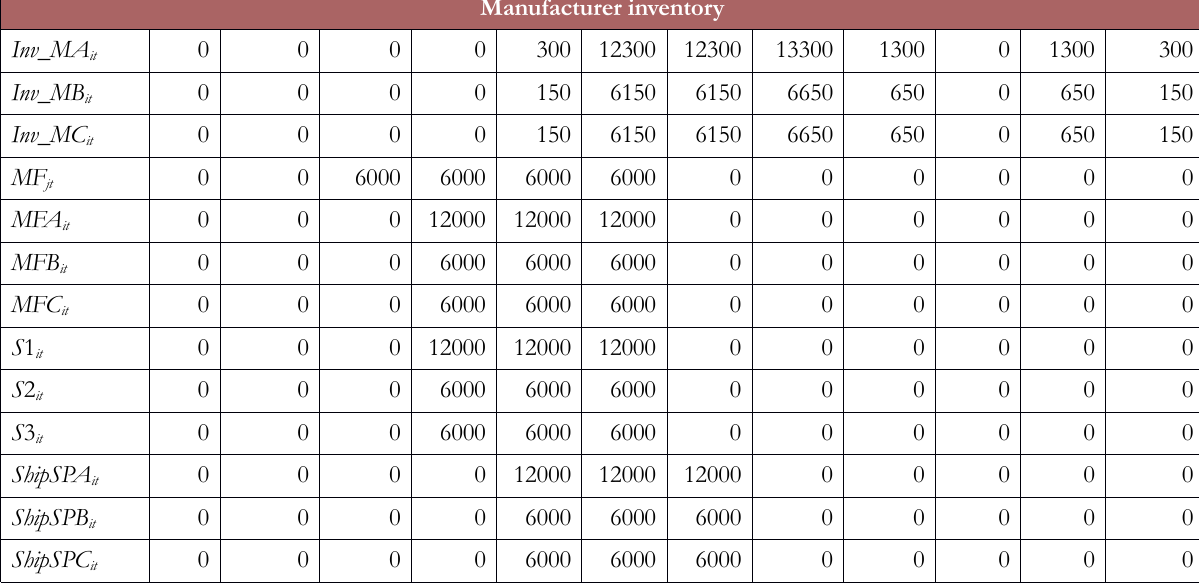
Table 2. Computational